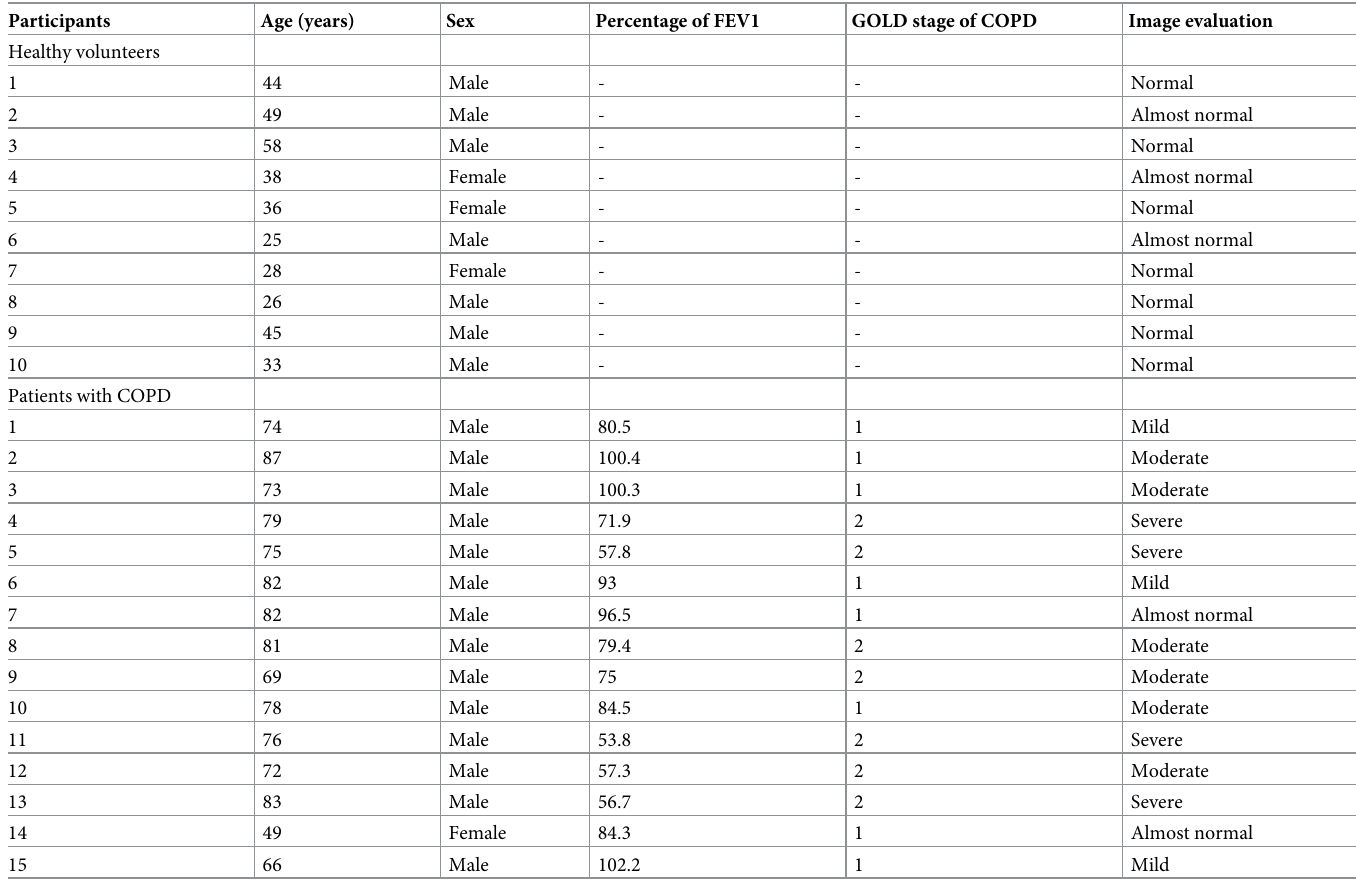
Table 1. Expert evaluations of each healthy volunteers and patients with